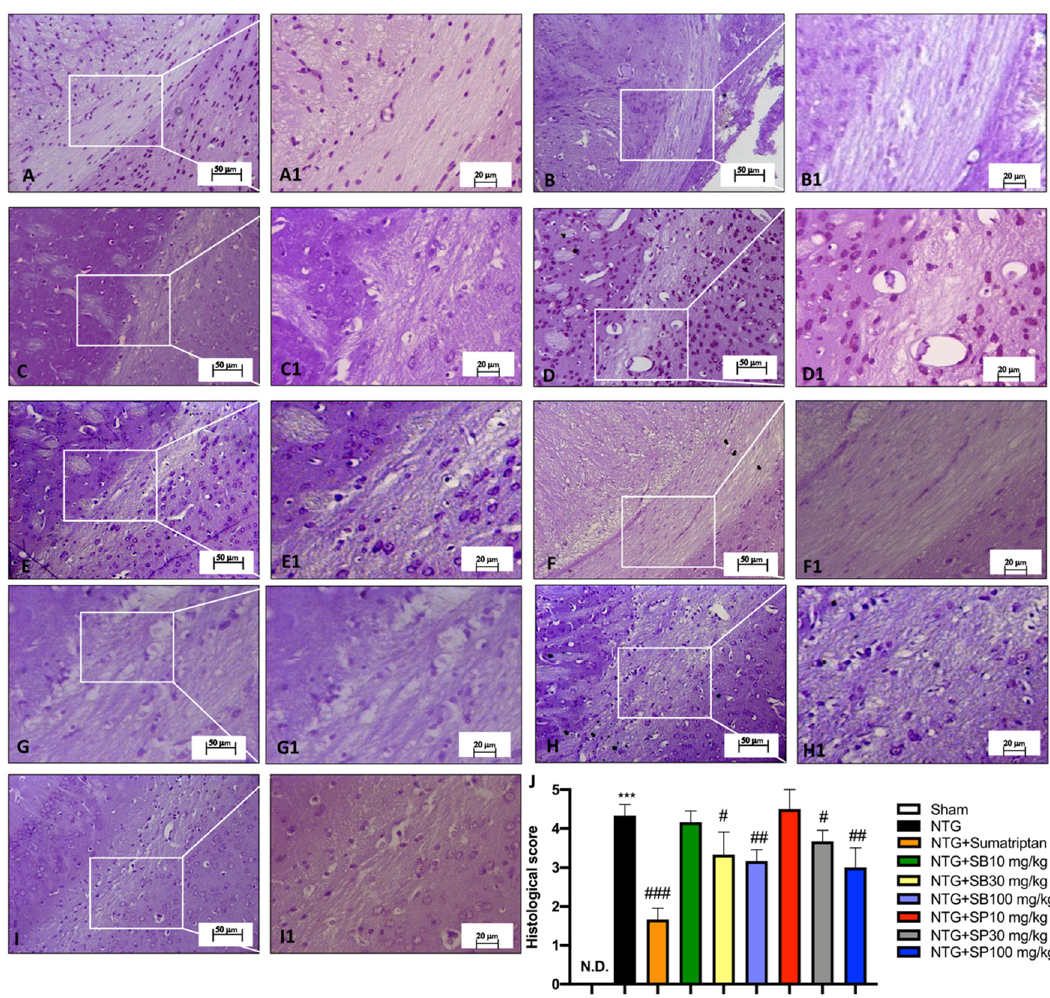
Figure 2. NTG-induced neurodegeneration in the trigeminal nucleus is attenuated by SCFA treatments. Cresyl violet staining shows alterations of the SpVC area in NTG-injected mice ( B , B1 , J ) compared to the sham group ( A , A1 , J ). Sumatriptan administration significantly reduces NTG damage in mice ( C , C1 , J ). SCFA treatment, at the highest doses ( E , E1 , F , F1 , H , H1 , I , I1 , J ), appreciably restores the trigeminal neurons of the SpVC area in a more effective way than SCFAs at a dose of 10 mg/kg ( D , D1–G , G1 , J ). Data are representative of at least three independent experiments. One-way ANOVA test. N.D.: Not Detectable; *** p < 0.001 vs. sham; # p < 0.05 vs. NTG; ## p < 0.01 vs. NTG; ### p < 0.001 vs. NTG. N = 10 mice/group for each technique.